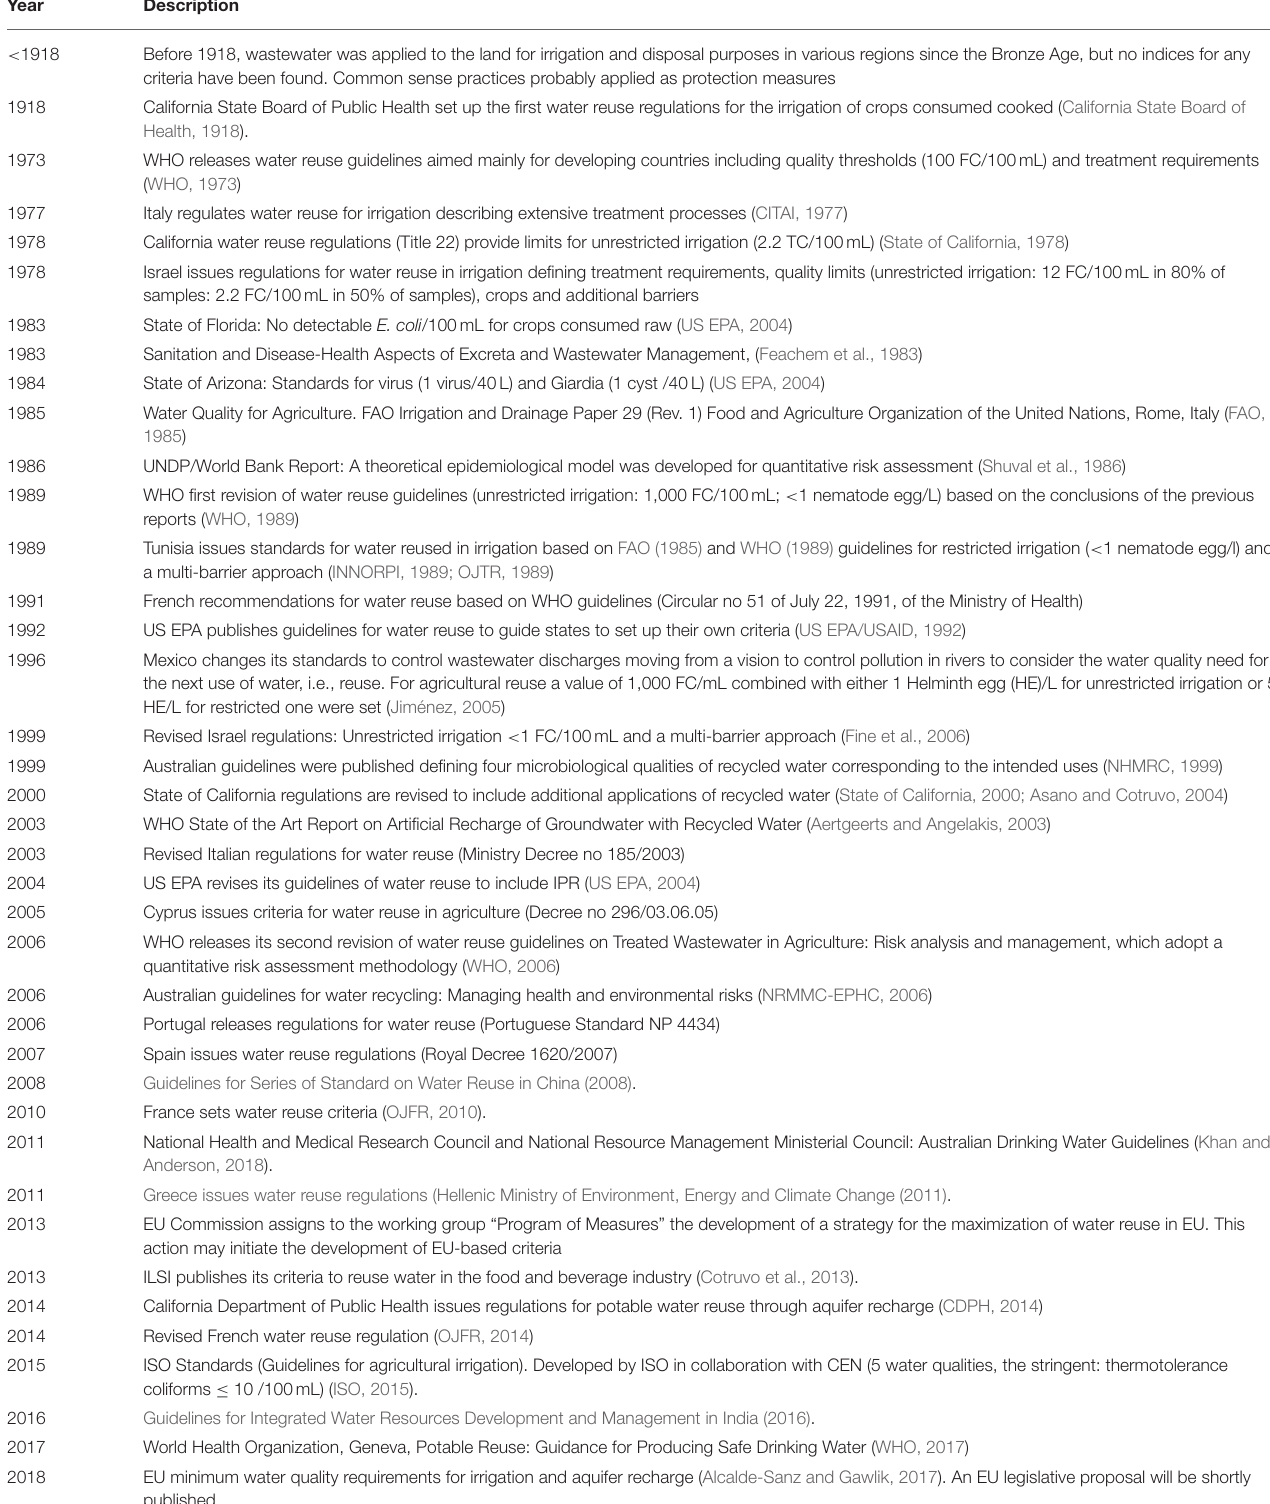
TABLE 4 | Timeline of water reuse criteria, regulations, and standards worldwide a